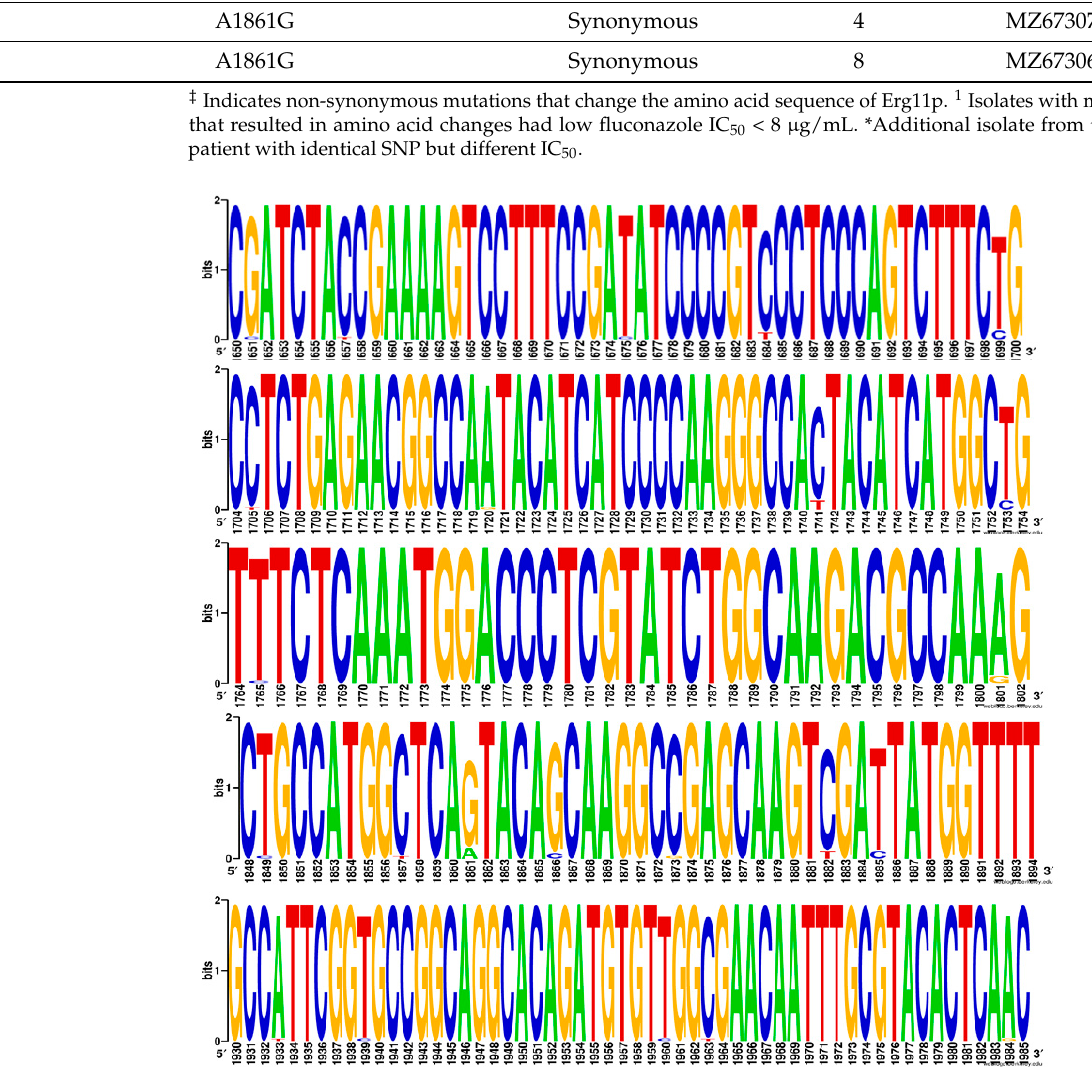
Figure 1. Sequence logo showing the SNPs within the C. neoformans ERG11 gene. The synonymous polymorphism A1861G was present in all the clinical isolate se- quences except isolate numbers 110414 (MZ673086), 110414 D3 (MZ673087), 110399